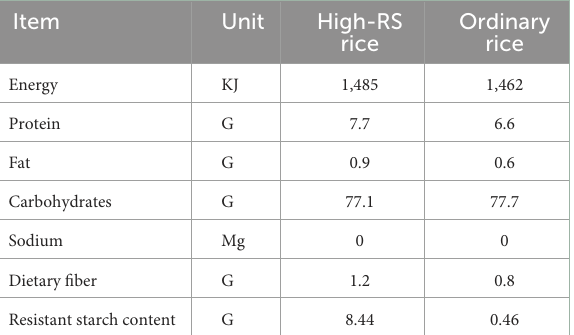
TABLE 1 Nutrition facts of test rices ∗ (per 100g refined